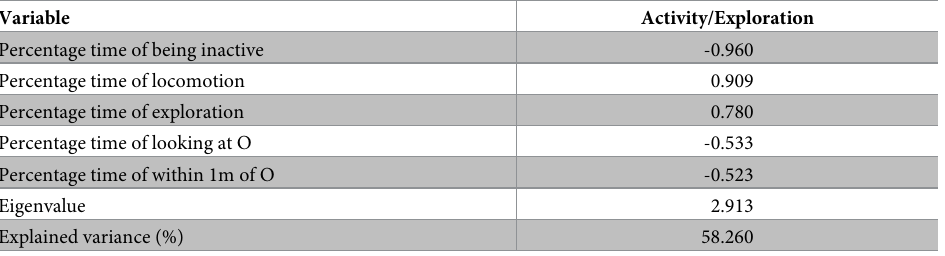
Table 4. Component derived from PCA on the variables measured in the exploration subtest.